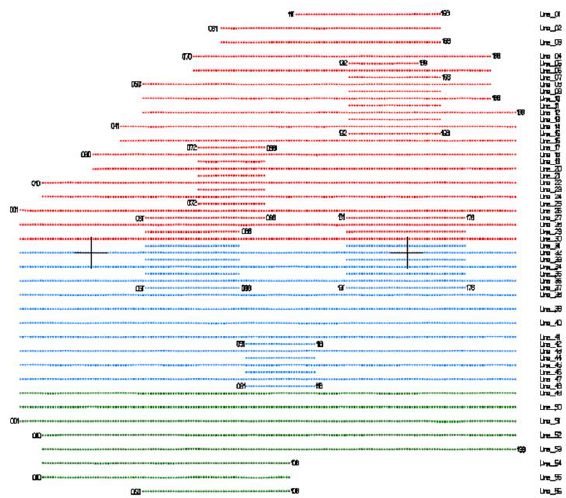
Figure 5. Aerial survey project - Q60% and Q30% combination The other aerial survey parameters behave identically to the